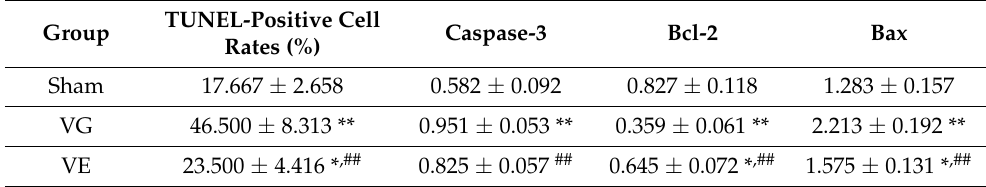
Table 3. Detection of apoptosis of the neurons in the hippocampus ( n = 6). TUNEL-Positive Cell Group Rates (%)